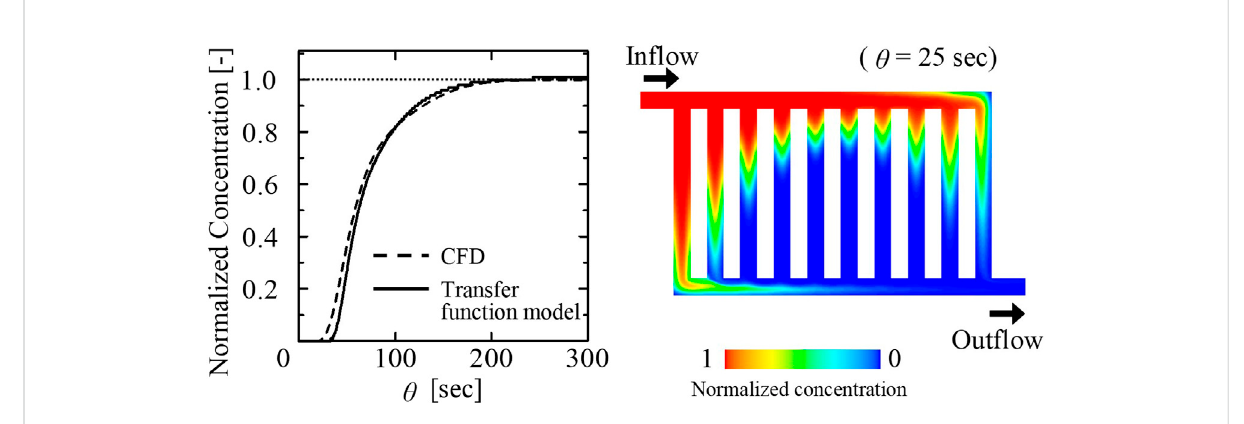
FIGURE 11 RTD curve (left) and contour plot of tracer concentration at z = 250 µm (right).